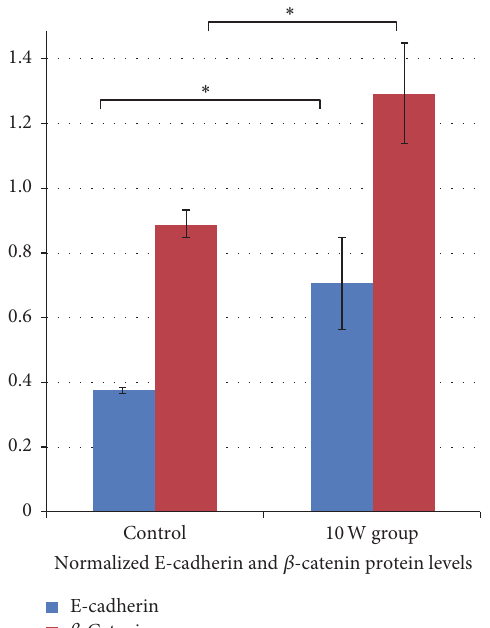
Figure 4: The expression of 𝛽 -catenin and E-cadherin in the sensory epithelium changed after applying CO 2 laser irradiation. Surface views of the organ of Corti in the basal turn ((a), (c), (e), and (g)) in the control group and ((b), (d), (f), and (h)) in the 10W laser group. The samples were stained for phalloidin (green, (c), (d)), 𝛽 -catenin (red, (e), (f)), and E-cadherin (blue, (g), (h)). In the 10W laser group, we observed overexpression of 𝛽 -catenin (red) and E-cadherin (blue) in the damaged surface of the outer hair cells. ((i), (j)) Western blot analysis of E-cadherin (i) and 𝛽 -catenin (j) proteins in the cochleae of the 10W laser and control groups, which is quantified and plotted in (k). The densities of the E-cadherin and 𝛽 -catenin protein bands were normalised with GAPDH ((i), (j)). Data are presented as means + SD; 𝑛 = 15 , ∗ 𝑃 < 0.05 . Scale bar: 20 𝜇 m. pha: phalloidin; E-cad: E-cadherin; 𝛽 -cat: 𝛽 -catenin. Scale bar: 20 𝜇